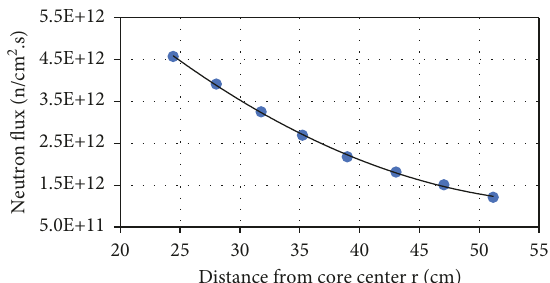
Figure 5: Average neutron flux distribution in the graphite